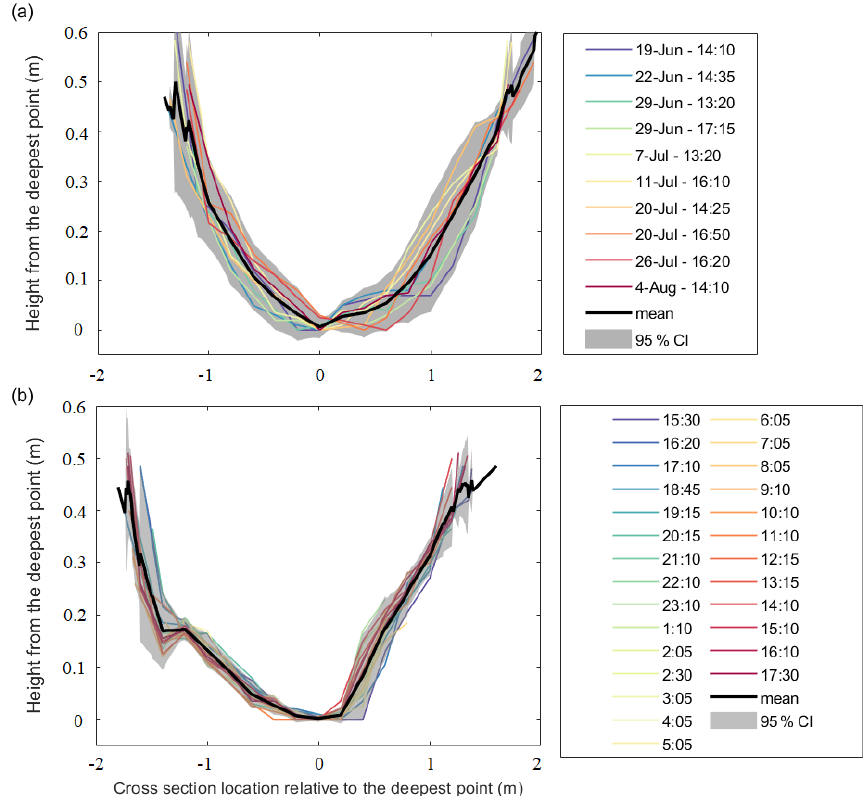
Figure 3. Stream cross-section depth profiles along the wetted perimeter: (a) daily cross-sections using measurements performed from 19 June through 8 August, with samples collected on average every 3–7d, and (b) hourly cross-sections using measurements from 15:30 on 26 July to 17:30 on 27 July 2016. The horizontal axes in these depth profiles have been adjusted so that the zero points co-occur with the maximum depth in each sample (due to which the profiles do not align perfectly with each other in panels a and b ). The mean profile is shown in a thick black line, and uncertainty (95%CI) is shown in the grey-shaded area. All times correspond to local